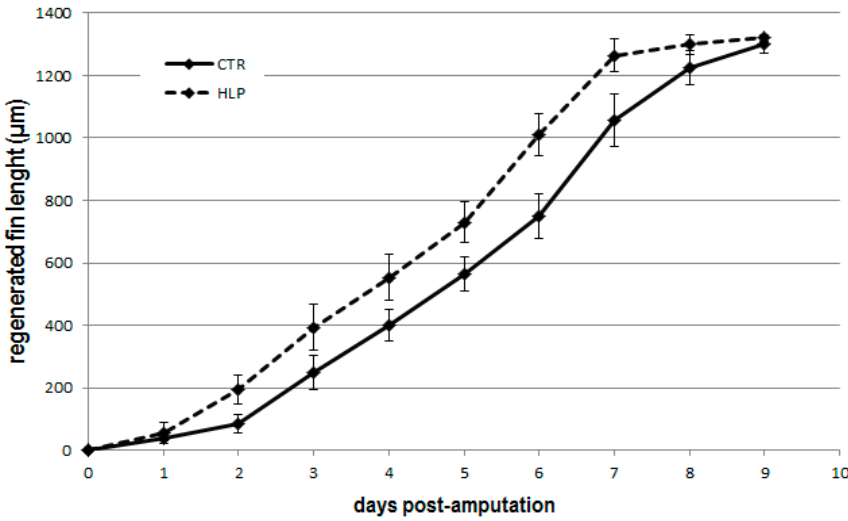
Figure 6. Daily measurements of regenerated fin length in untreated (CTR, 7 fish) and treated with HI LF-PEMFs (HLP, 7 fish) adult zebrafish.